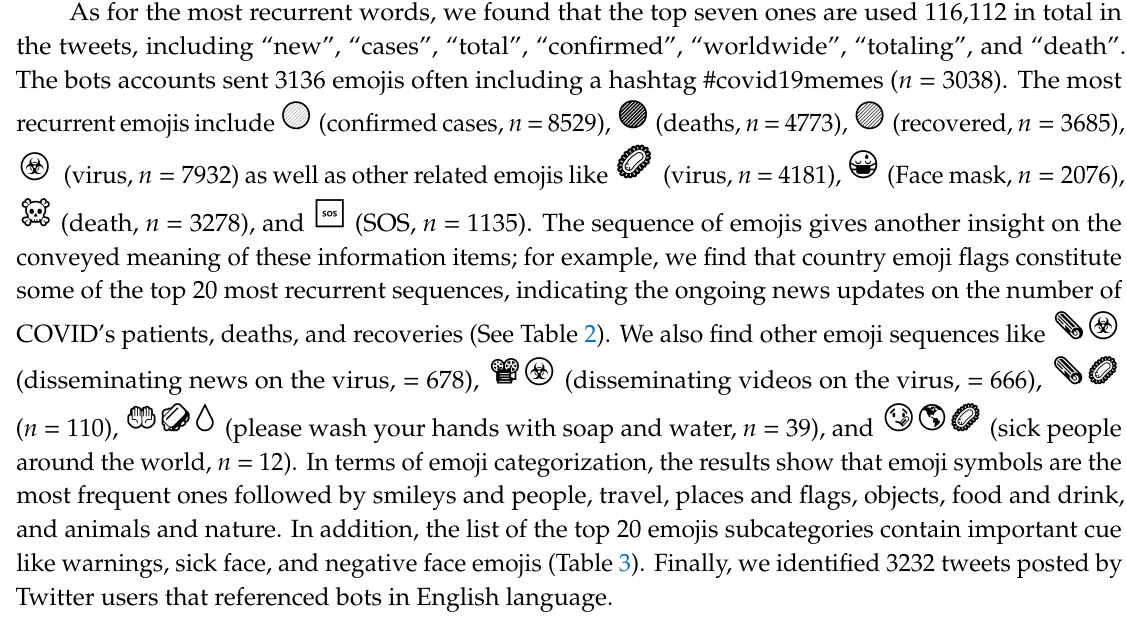
Table 2. The top 20 most frequent emoji sequences.